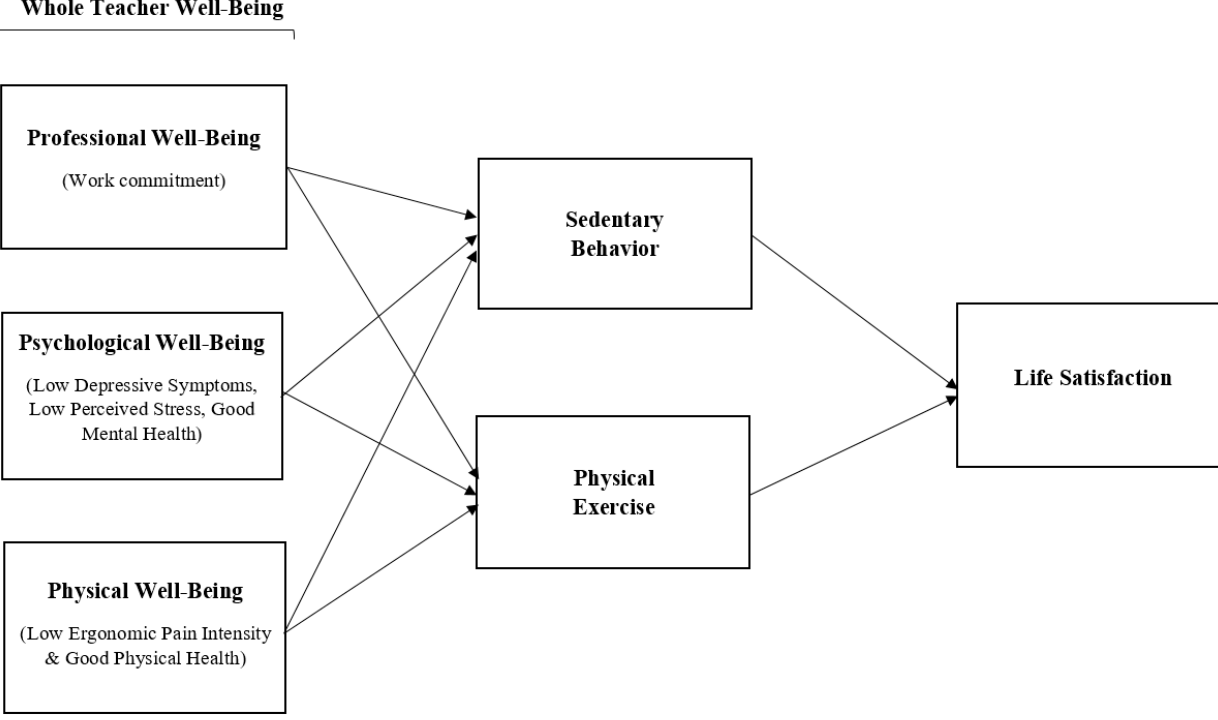
Figure 2. Physical Activity Mediation Model of Well-being and Life Satisfaction.